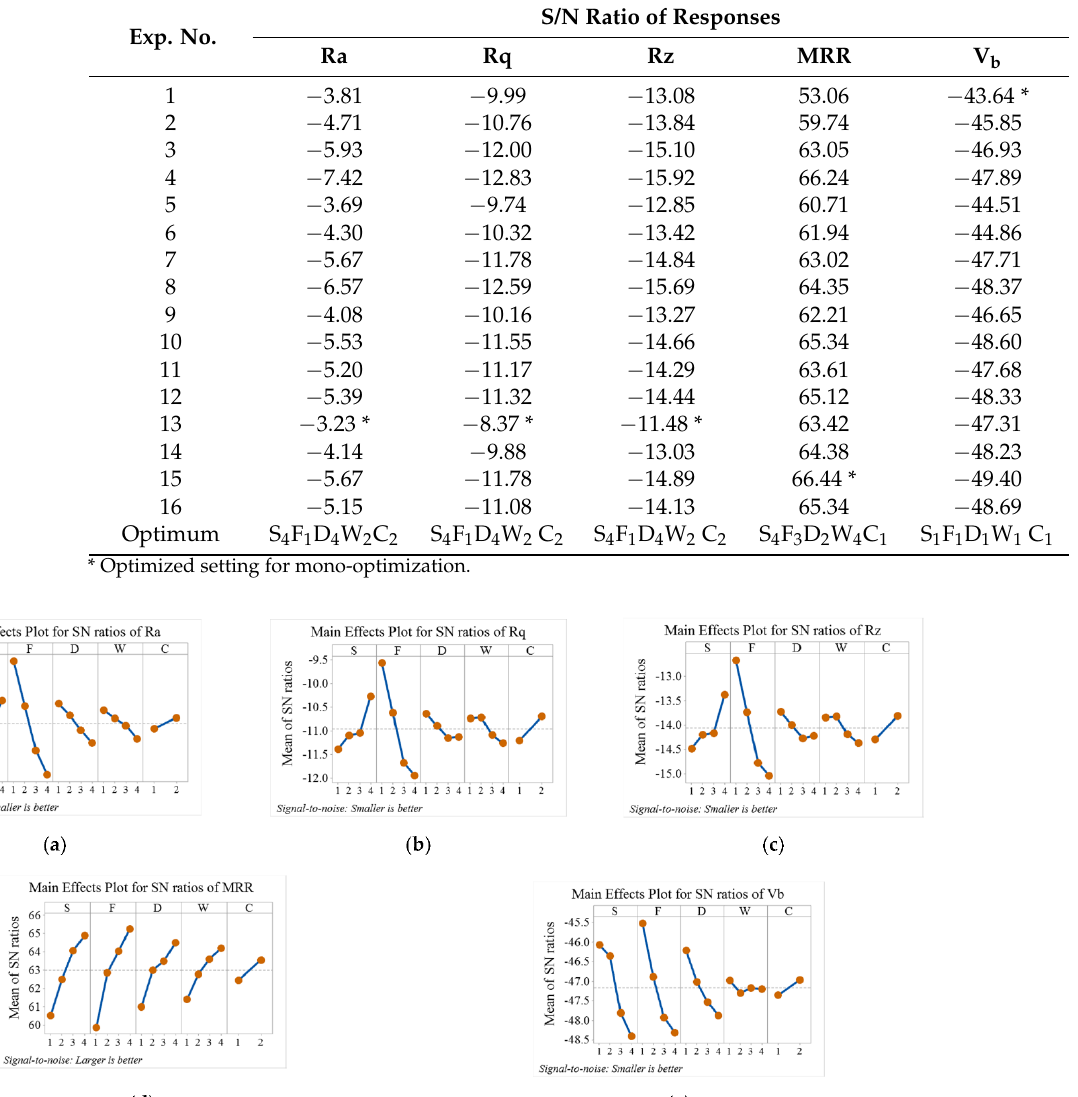
Table 6. S/N ratios of responses.